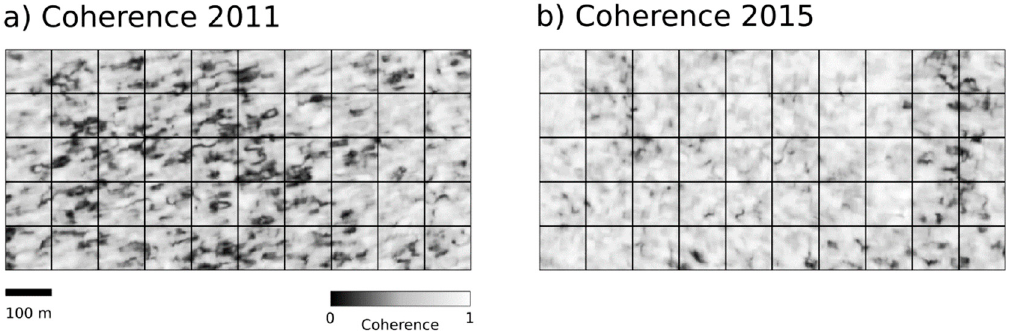
Figure A5. TanDEM-X-derived interferometric coherence for the years 2011 ( a ) and 2015 ( b ) on the BCI 50 ha plot.